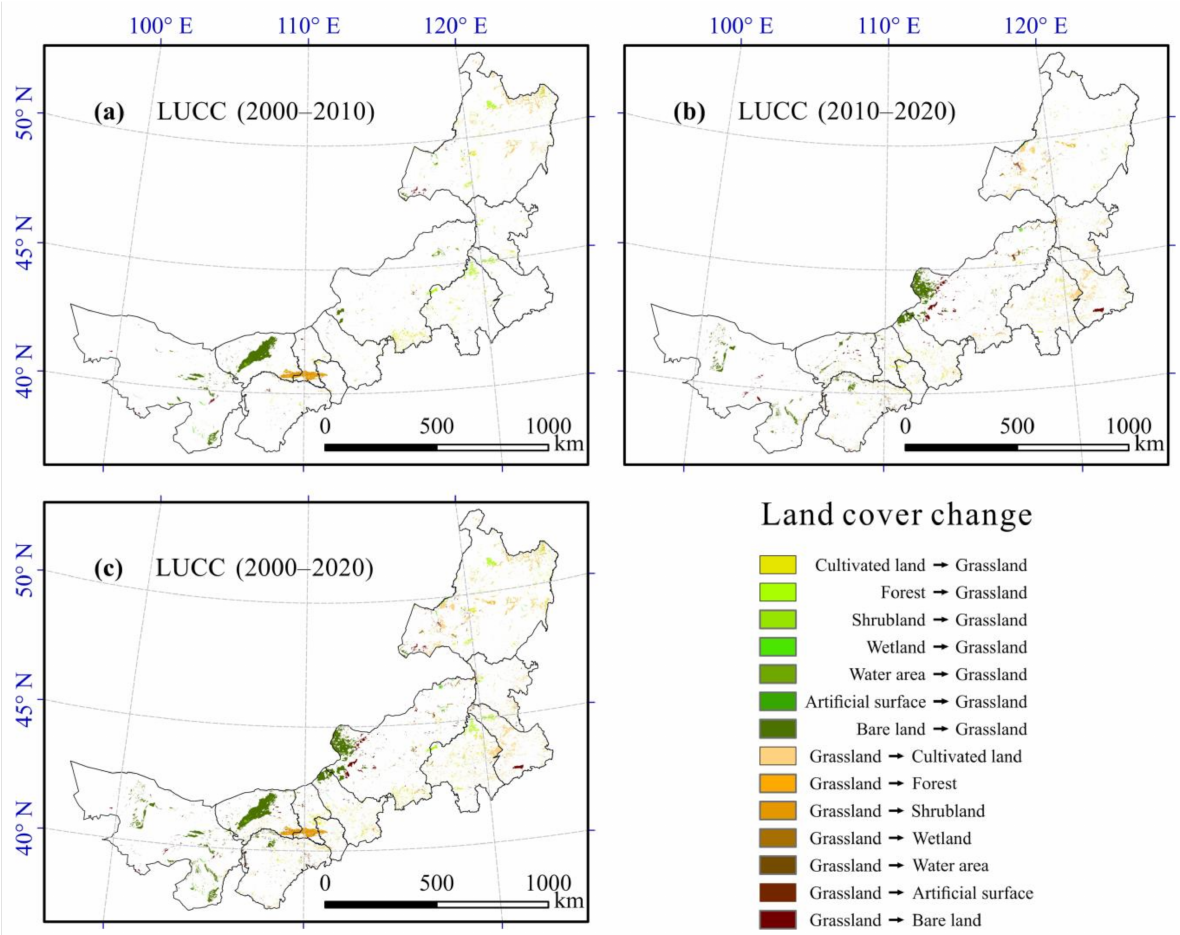
Figure 3. Land-use change in Inner Mongolia related to grassland during: ( a ) 2000–2010; ( b ) 2010–2020; and ( c )